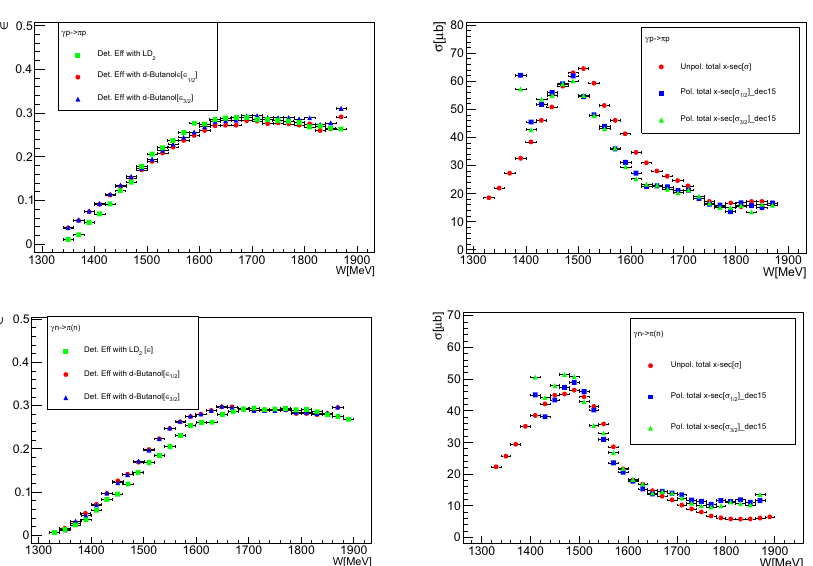
Figure 2. Detection e ffi ciency and total cross section comparison for γ p ( n ) → π 0 π + n ( n ) (above row) and γ n ( p ) → π 0 π − p ( p ) (bottom row).For e ffi ciency spectra:Green symbols for unpolarized liquid deu- terium target, Red symbols for polarized dButanol target with negative helicity state and Blue symbols for polarized dButanol target with positive helicity state; For cross section plots: Red symbols for unpo- larized liquid deuterium target, Blue symbols for polarized dButanol target with negative helicity state and Green symbols for polarized dButanol target with positive helicity state.